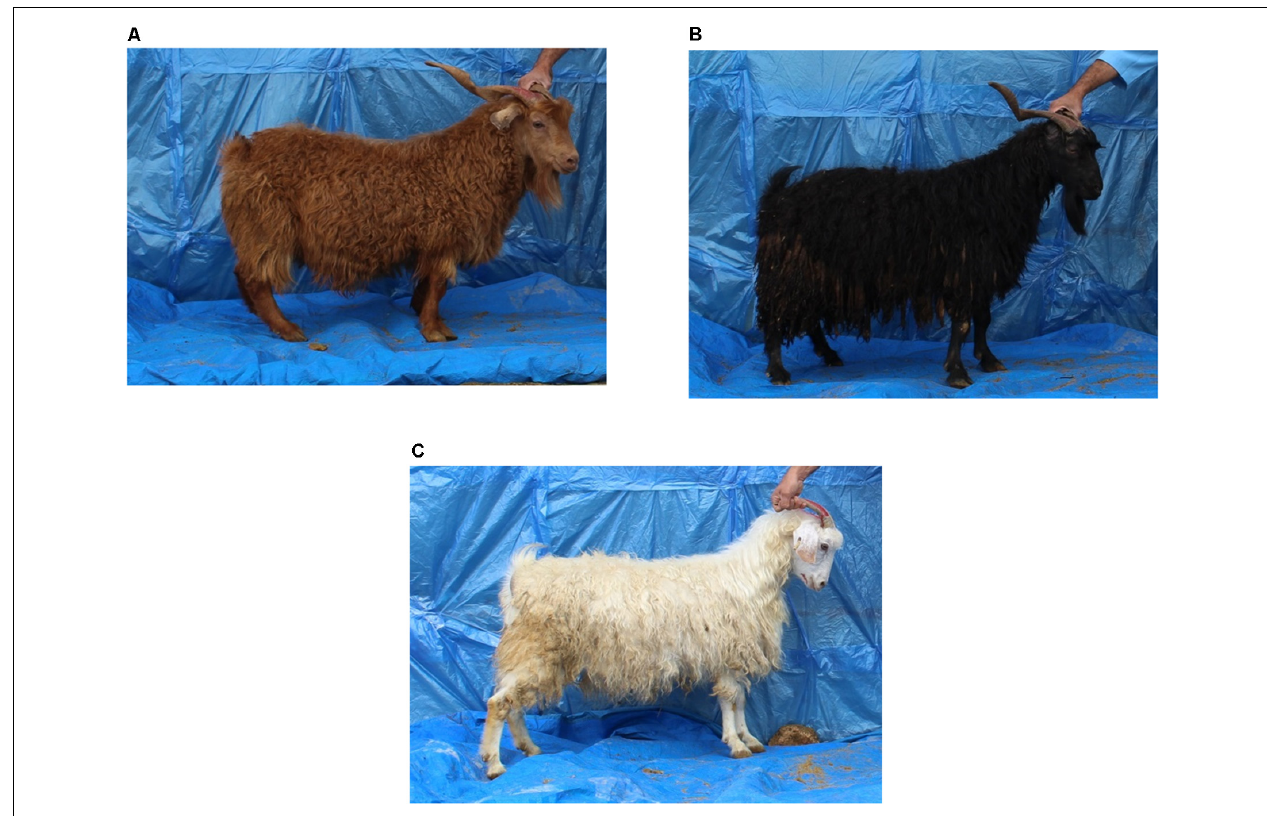
FIGURE 1 | Coat color variation in Markhoz goats used for a genome-wide association study. (A) Brown ( n = 168), (B) black ( n = 26), (C) white ( n = 26). TABLE 1 | Genome-wide association studies conducted for coat color and mohair traits in Markhoz goats. Trait Model # Individuals